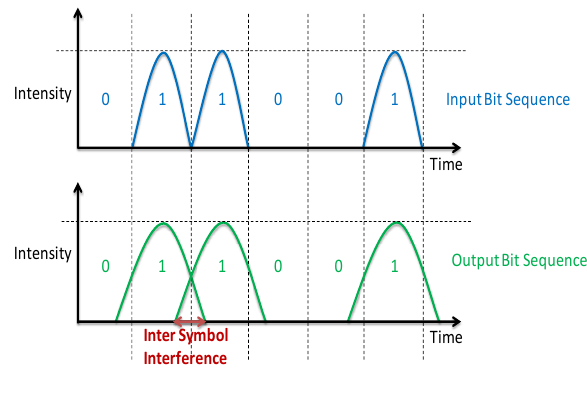
Figure 1. Inter Symbol Interference in digital communication